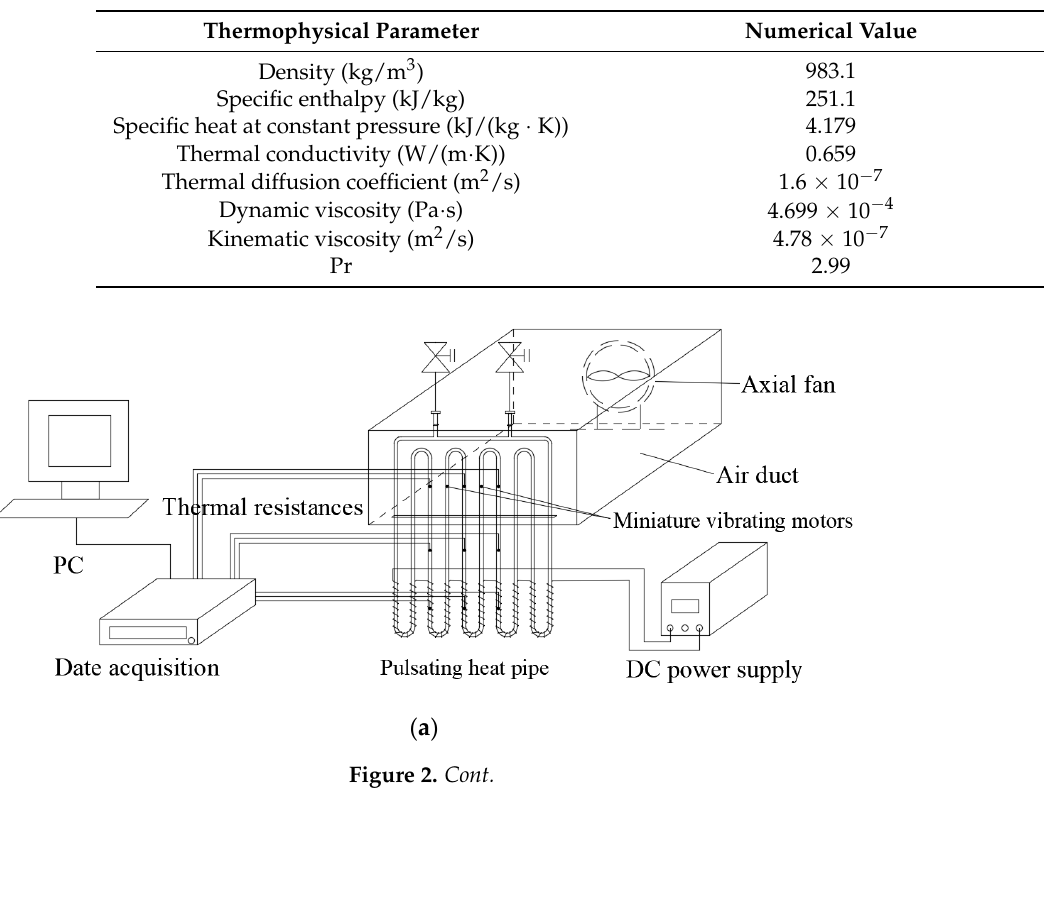
Figure 1. Positions of the temperature sensors and miniature vibrating motors on the PHP for the experimental study. Table 2. Thermophysical properties of the working medium (in a saturation state, the qualitative temperature is 60 °C).